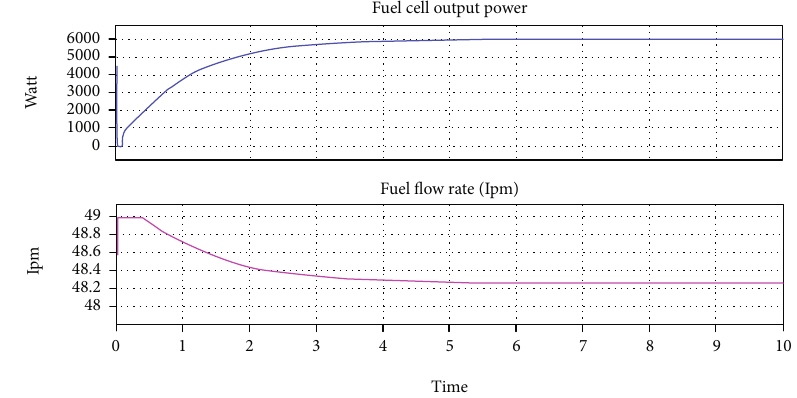
Figure 18: Simulation results for the DNN-fuel cell power with respect to optimum fuel fl ow.